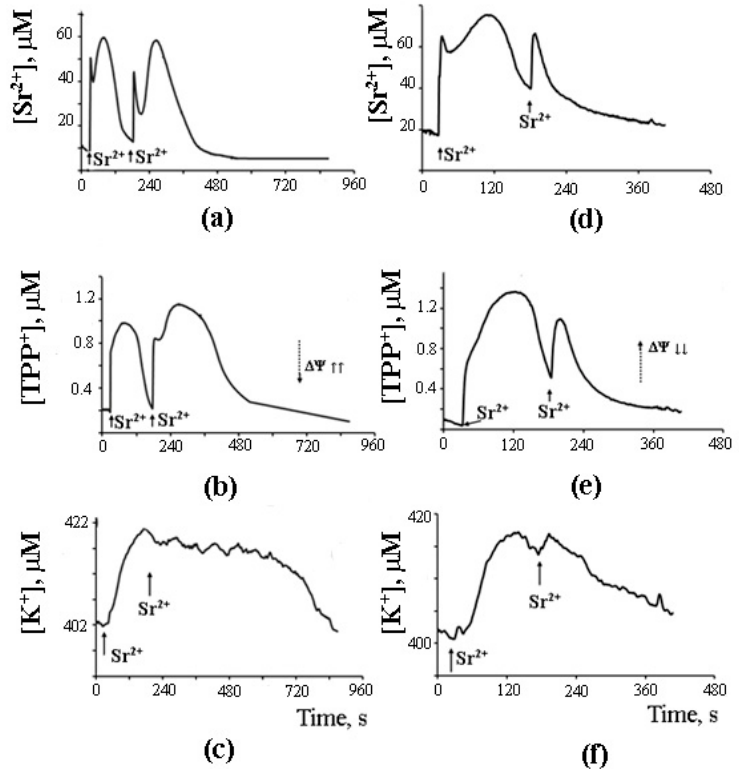
Figure 7. Sr 2+ -induced cyclic changes in the external concentrations of Sr 2+ , TPP + , and K + ions in the suspension of rat liver mitochondria in the absence ( a – c ) or presence ( d – f ) of 15 µM AACOCF 3 (phospholipase A2 inhibitor). Addition: 47 nmol SrCl 2 /mg of the protein. The medium was the same as in Figure 6. The concentration of the mitochondrial protein was 2 mg/mL. Typical curves are shown ( n = 6). Adapted from Mironova et al. Biochim. Biophys. Acta. 1848 (2015): 488–495.